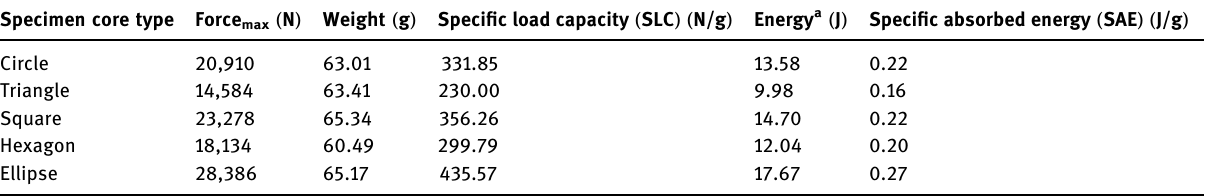
Table 4: Simulation results of the aluminium alloy perforated sheet metal ( linear arrangement ) obtained from fi nite element